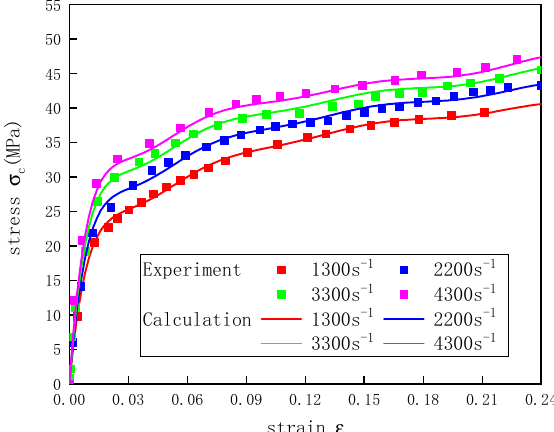
◦ C and di ff erent strain